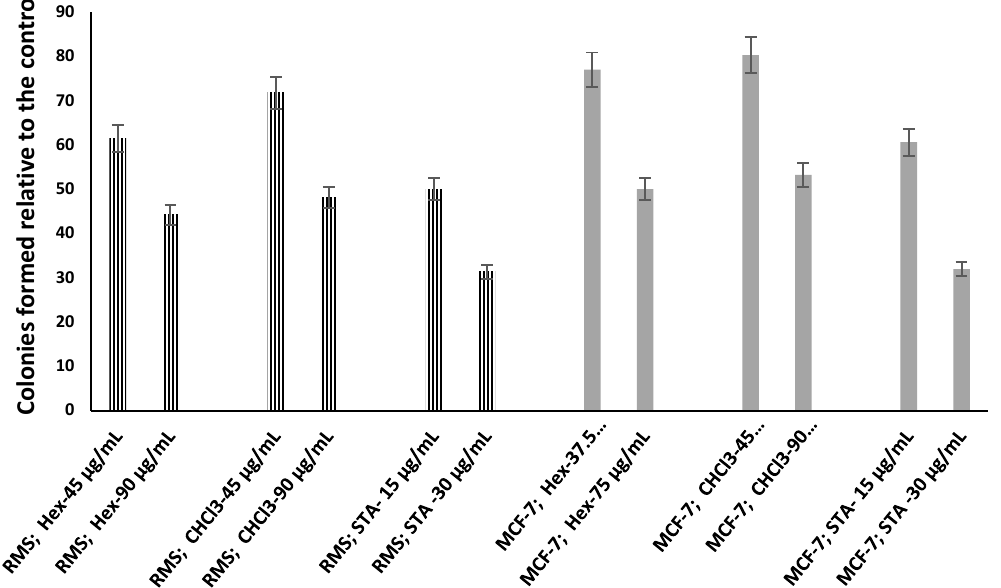
Figure 1. Percentage of colonies formed by RMS and MCF-7 cells after treatment with hexane and chloroform fractions of C. minima methanol extract, compared to the standard cycloheximide. Data are expressed as mean ± SD, n = 3.